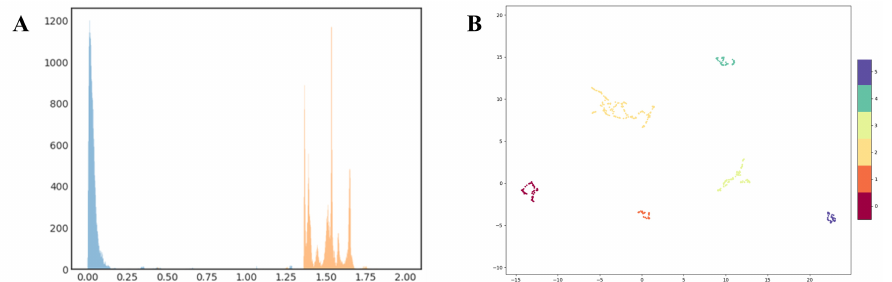
Figure 8. Distributions of distances and uniform manifold approximation and projection (UMAP) visualization, ( A ) genuine–imposter distributions of shark images, ( B ) UMAP plots of representation vectors of images in the known test set. Different color represents different shark